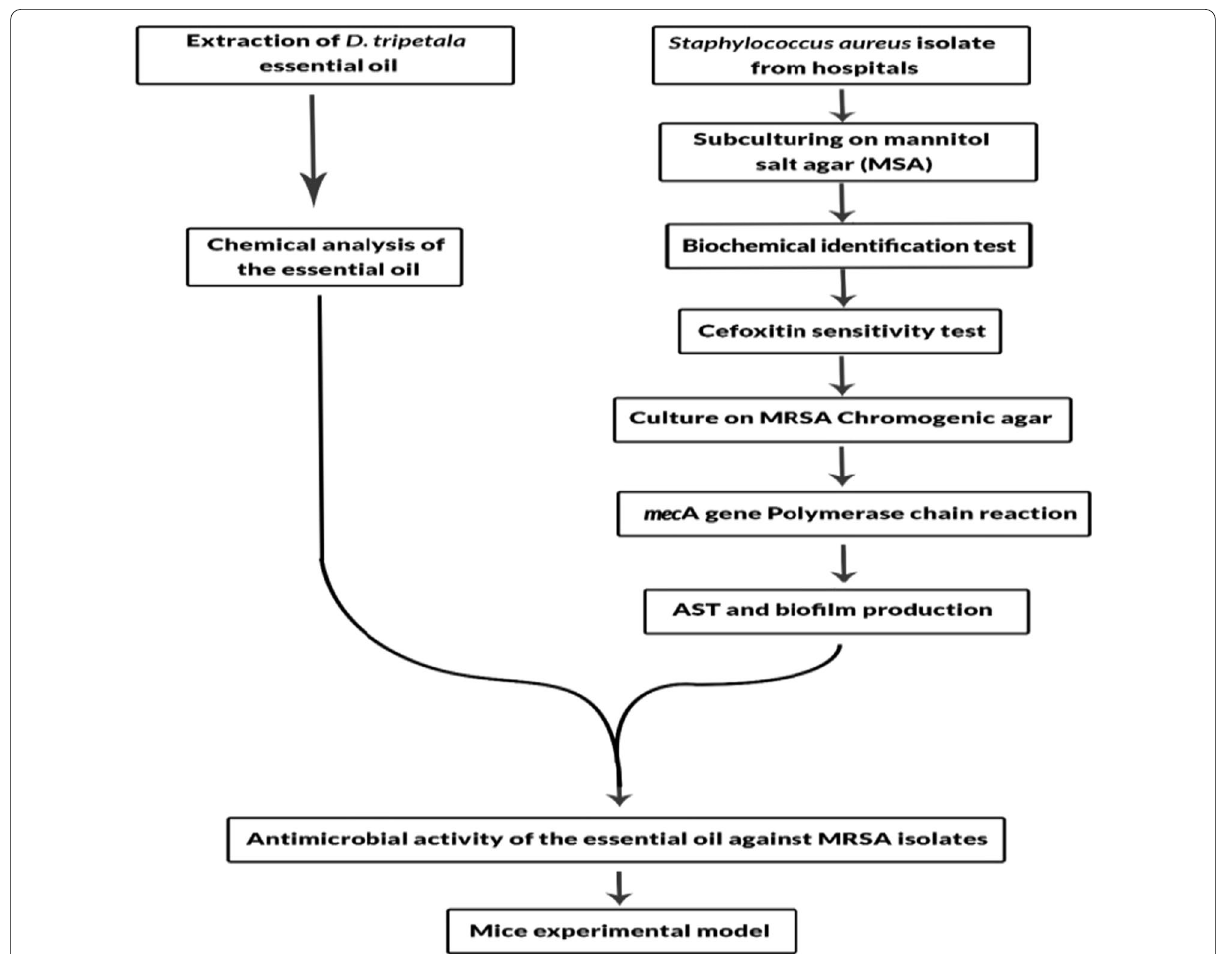
Fig. 1 Flow-diagram of the study